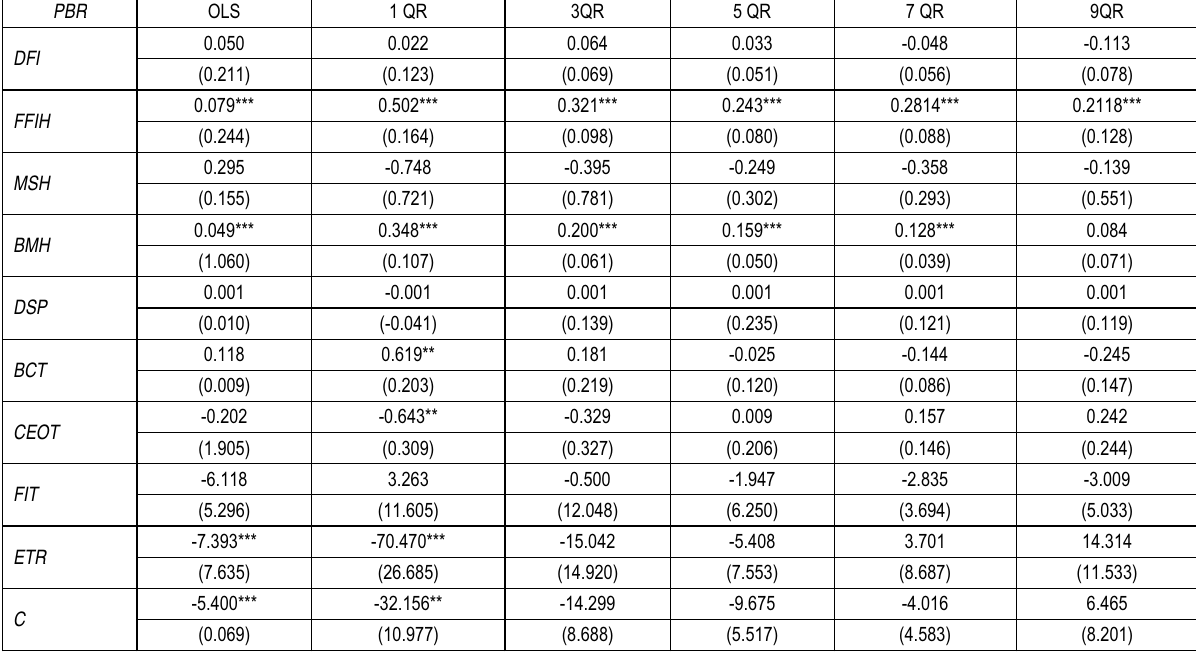
Table 6 (cont.). The results of quantile regression on P/B ratio ( PBR